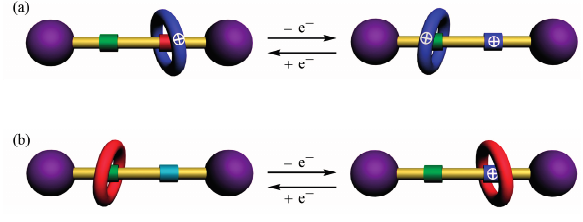
Figure 1. Cartoon representations of ( a ) repulsion- and ( b ) attraction-type redox-controllable [2]rotaxane-based molecular